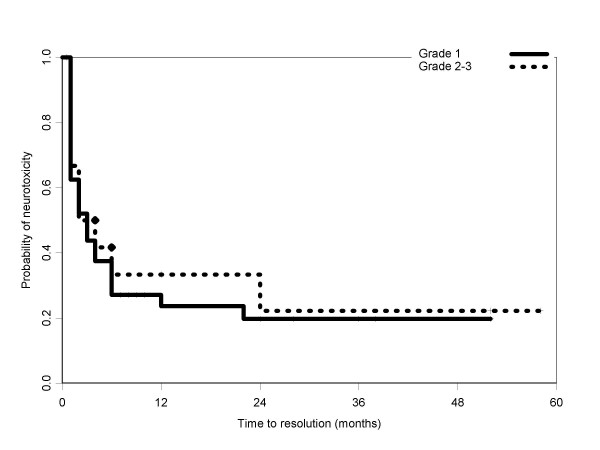
Kaplan-Meyer curve of time to resolution of neurological toxicity according to grade of toxicity reported during chemotherapy.